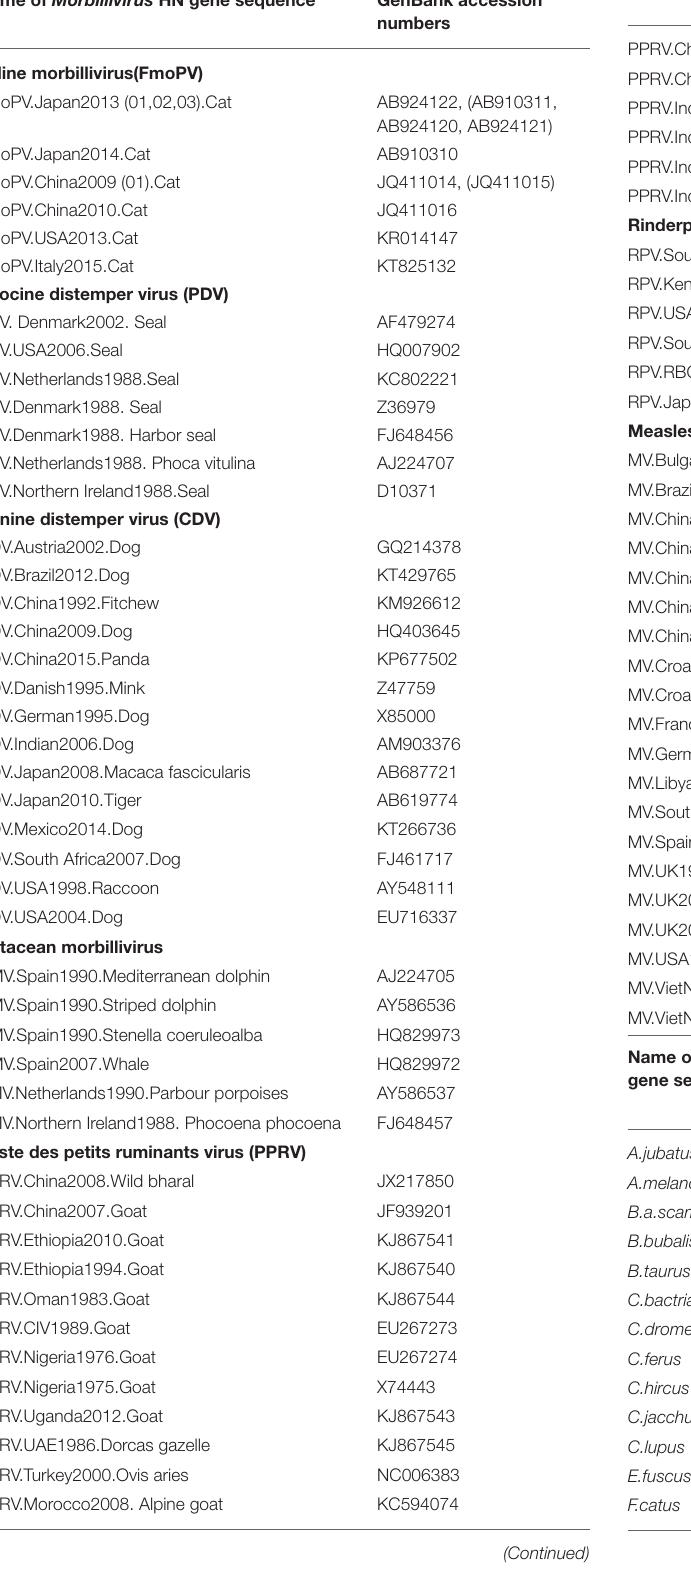
TABLE 2 | Morbillivirus Hemagglutinin and its receptors gene sequences used for comparison study. Name of Morbillivirus HN gene